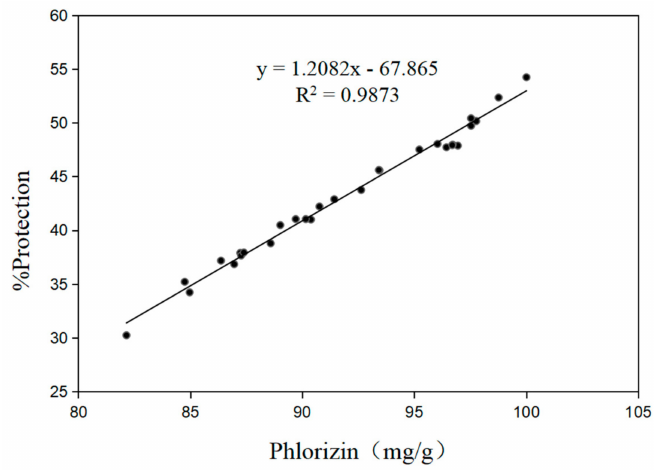
Figure 4. Scatter plot of the protection rate of human endothelial cells against hydrogen peroxide- induced oxidative stress versus phlorizin content of 29 M.toringoides